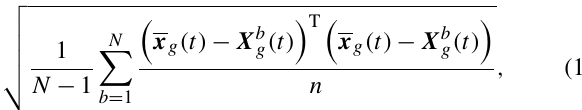
and (ii) the ratio of the ensemble spread with that of the (t)/ spread (t) ; each is on an interval of benchmark, spread g t δ t = 0 . 01 over the forecast t ∈ [ 0 , 20 ] . The integration step size for the Euler–Maruyama and the Runge–Kutta schemes are varied over { (cid:49) q = 10 − q } 3 , and the diffusion level is q = 2 varied, s ∈ { 0 . 1 , 0 . 25 , 0 . 5 , 0 . 75 , 1 . 0 }